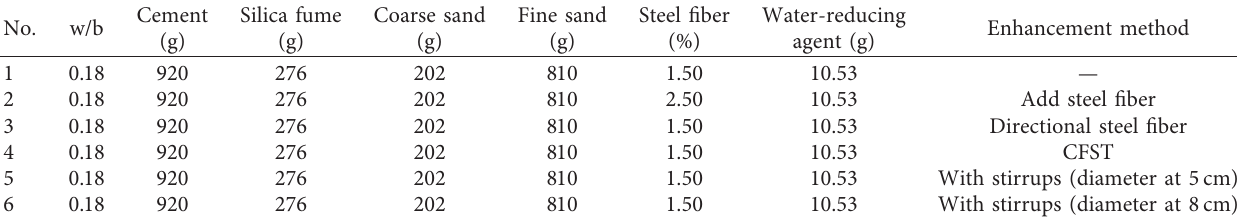
Table 2: Mix proportions of UHPC.